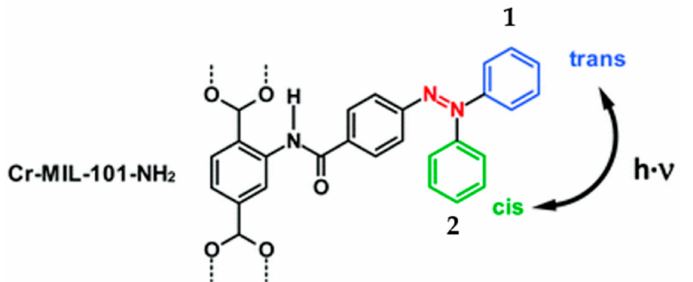
Figure 12. The product of Cr-MIL-101-NH 2 with p-phenylazobenzoylchloride ( 1 ) and 4-(phenylazo)phenylisocyanate ( 2 ). Blue amide and green urea